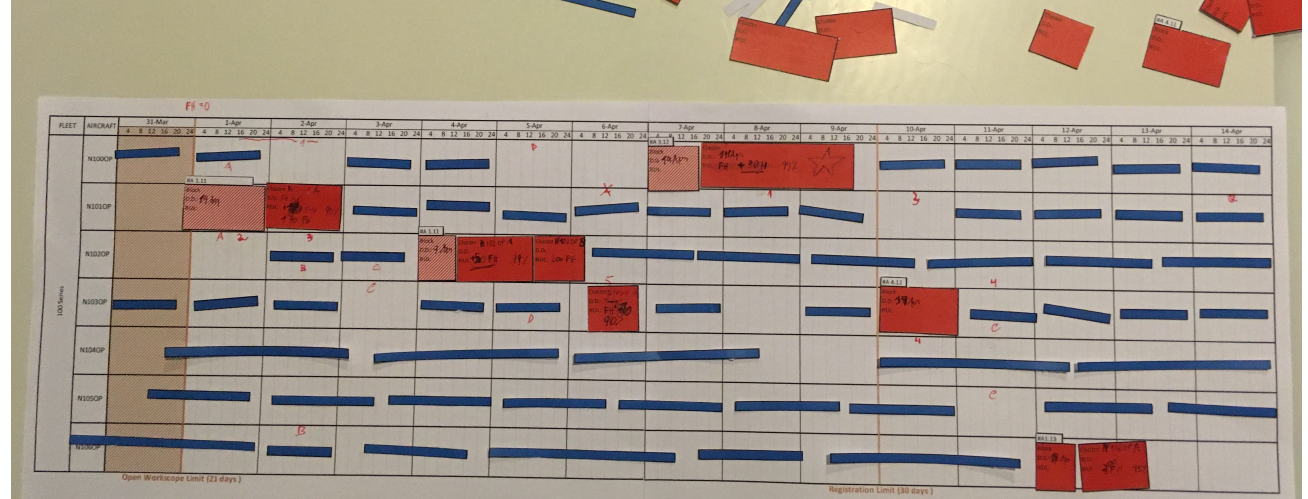
Figure 1. Paper prototype materials printed for